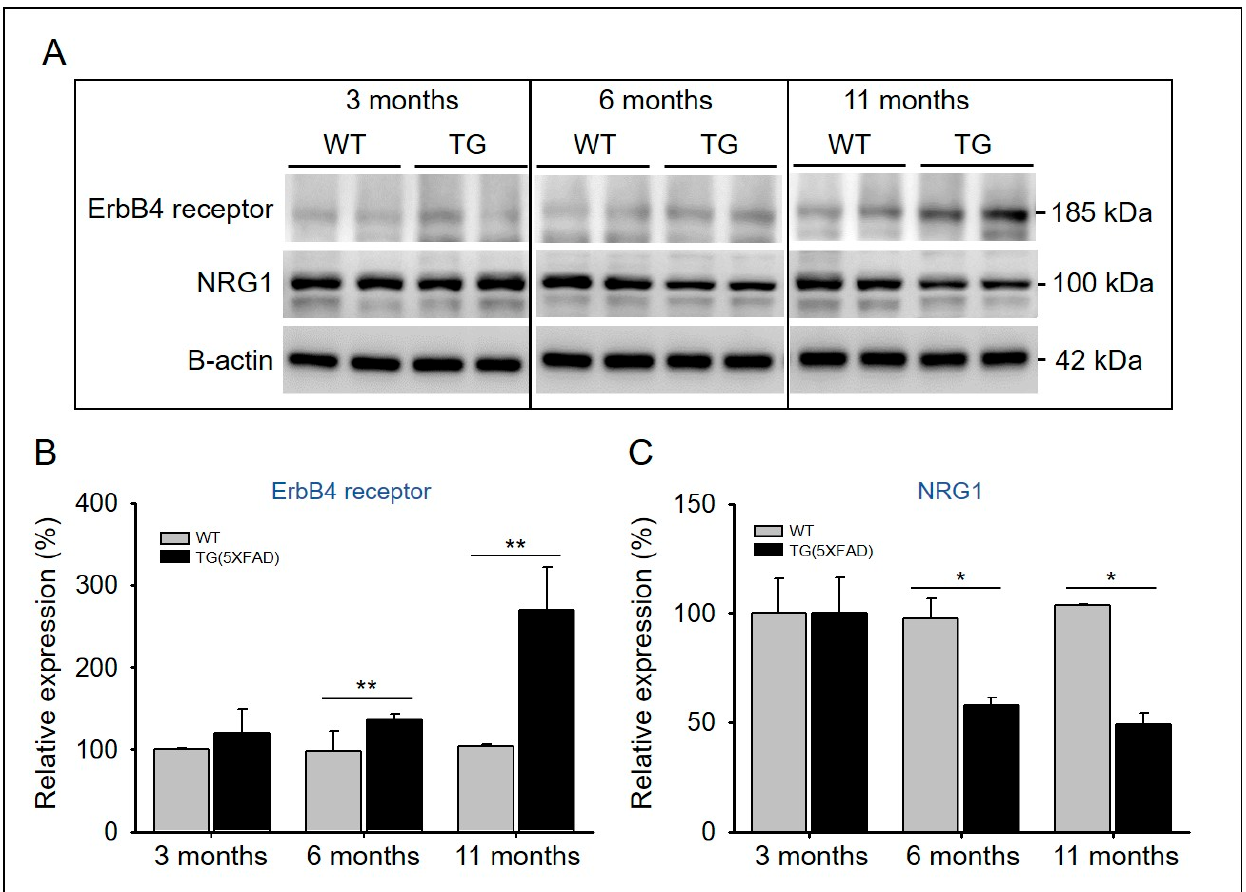
Figure 5. The expression levels of the NRG1 and ErbB4 receptor proteins. ( A ) The hippocampal expression levels of the NRG1 and ErbB4 receptors were performed with antibodies against NRG1, ErbB4 receptor, and β -actin (house keeping control). ( B , C ) The band intensities presented in panel A were measured by densitometry, normalized with those of β -actin, and expressed as relative fold-change in expressions. *, p < 0.05; **, p < 0.01 compared with the indicated group using unpaired t -test ( n = 3–5).